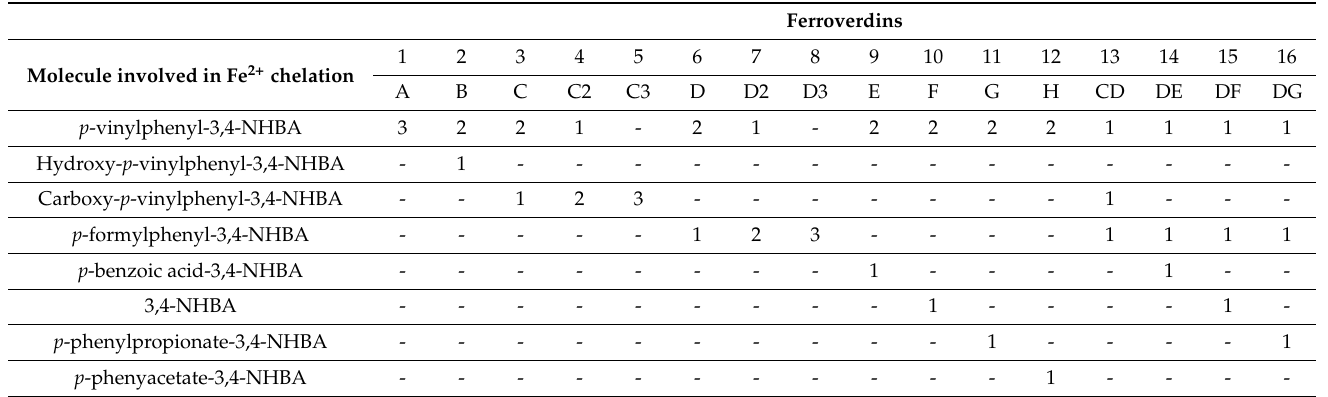
Table 2. Molecules involved in ferrous iron chelation in